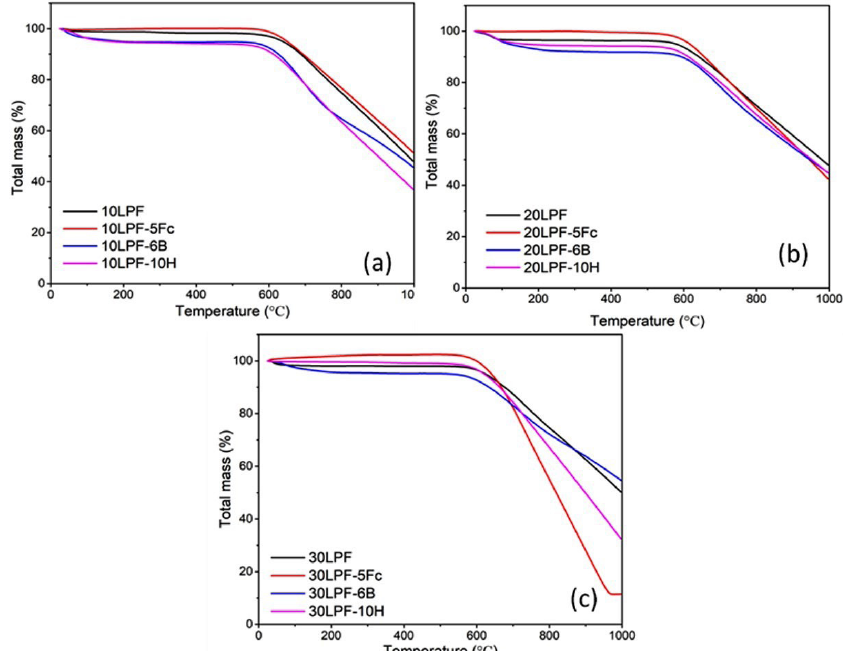
Figure 9. TG curves of carbon samples derived from plain LPF resin and the ones containing boron oxide, boric acid and ferrocene (a) 10LPF, (b)20LPF and (c) 30LPF, synthesized with 10 wt.%, 20 wt.% and 30 wt.% kraft lignin,